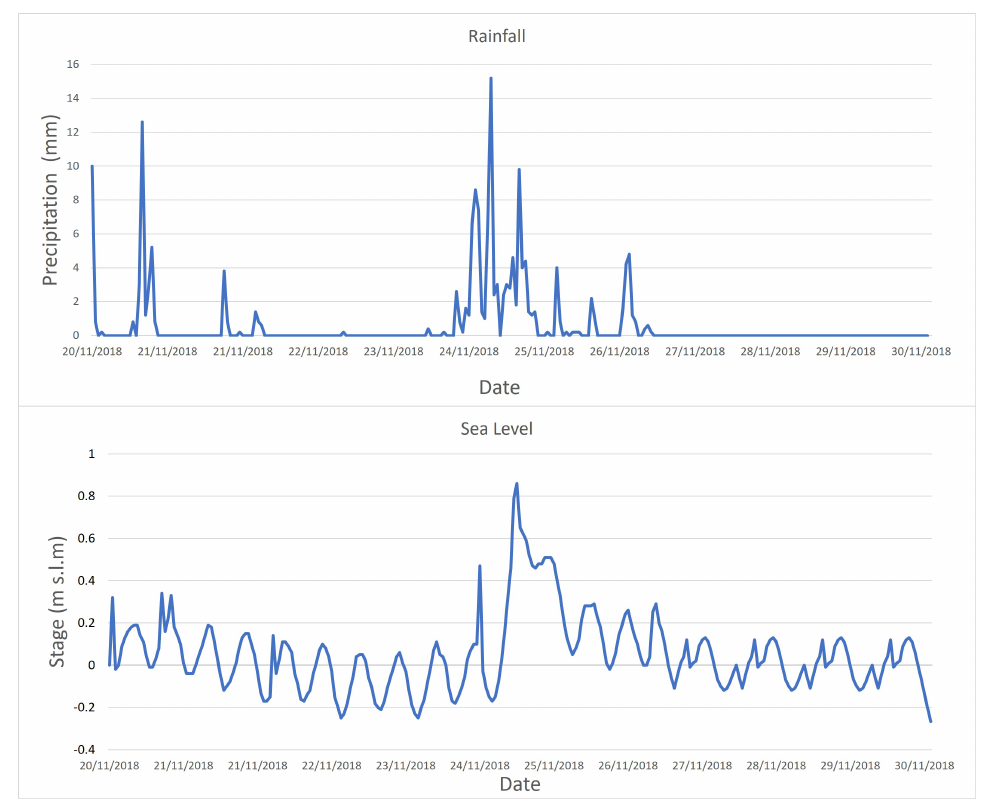
Figure 6. Hyetograph ( top ) and the sea level ( Bottom ) trend recorded during the event of 25 Novem- ber 2018